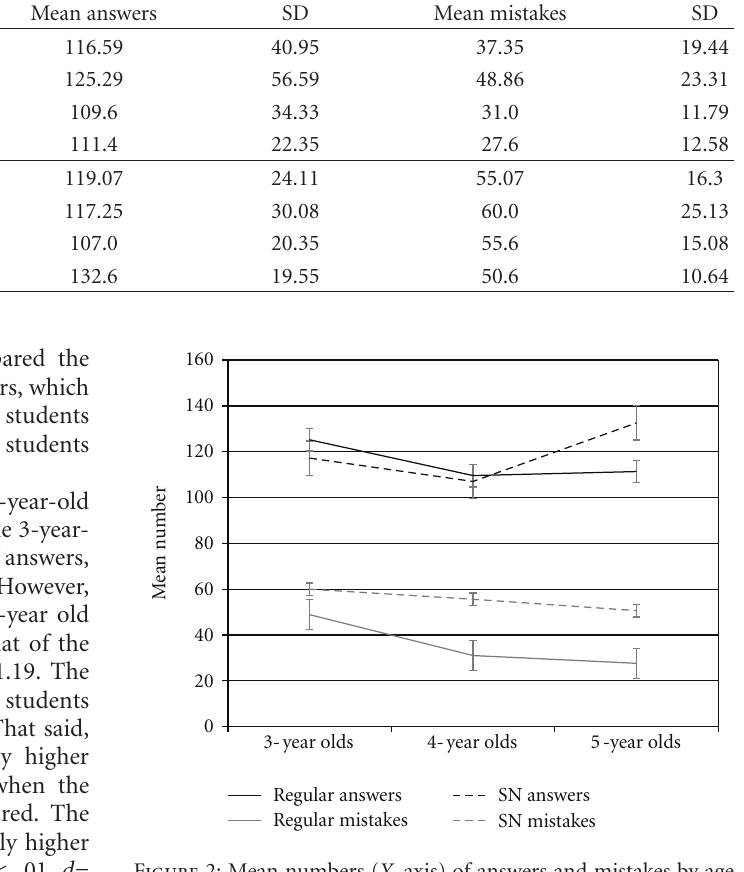
Figure 2: Mean numbers ( Y -axis) of answers and mistakes by age ( X -axis) for each